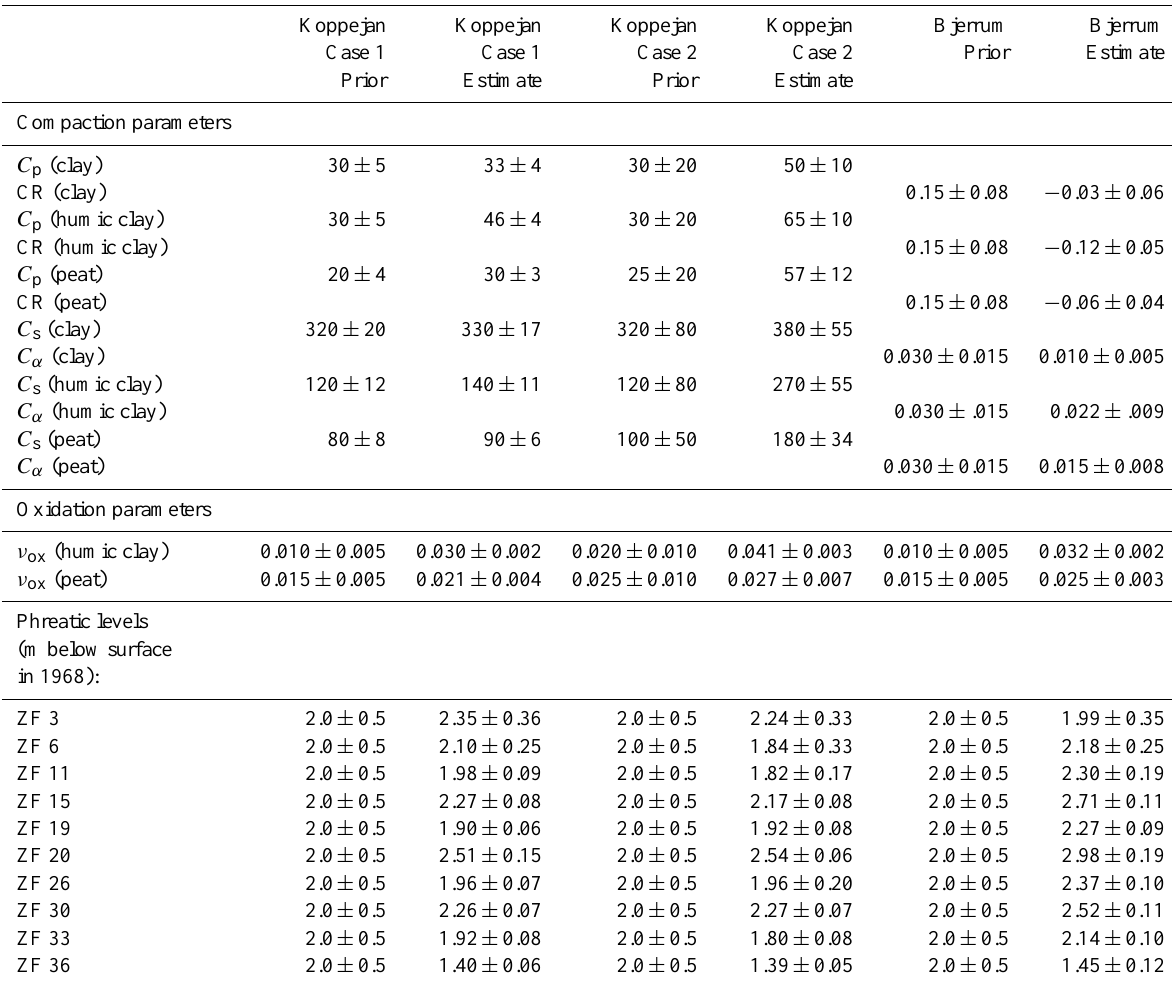
Table 1. Assimilation